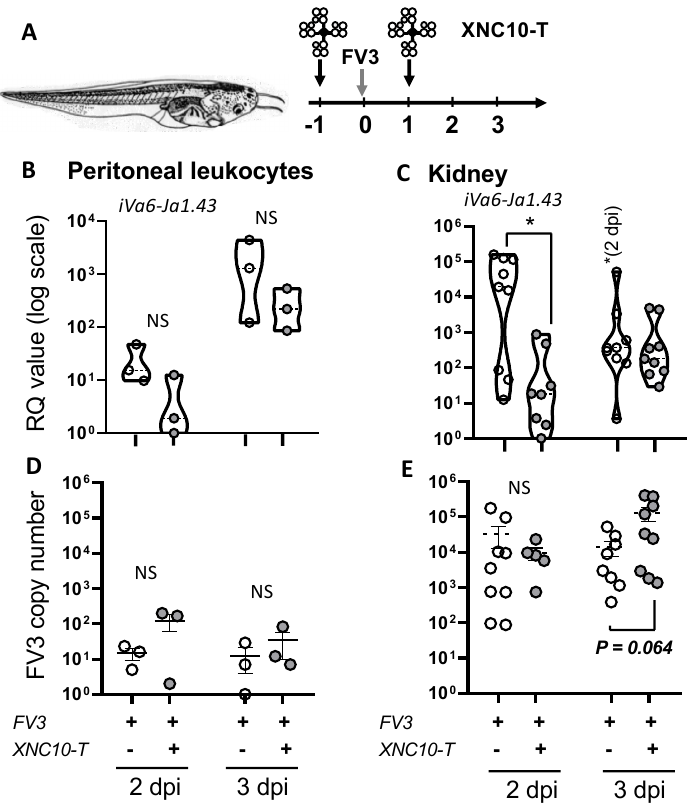
Figure 4. XNC10 tetramer-mediated iV α 6T cell depletion in tadpoles a ff ects iV α 6-J α 1.43 transcript levels and viral replication. PLs and kidneys were collected from three week-old (stage 55) tadpoles that had been injected with 1 µ g XNC10 tetramers (XNC10-T) or vehicle control 1 day pre, and 1 day post i.p. injected with 10,000 PFUs of FV3, at the indicated time points ( n = 9). A schematic of the injection regime is shown in ( A ). Gene expression of iV α 6-J α 1.43 in PLs ( B ) and kidneys ( C ) is shown. Results are normalized to an endogenous control and presented as relative expression compared with the lowest observed value according to the ∆∆ Ct method. FV3 loads in PLs ( D ) and kidneys ( E ) were measured using absolute qPCR with primers against FV3 polymerase II. For PLs, each dot represents a pool of 3 tadpoles, while for kidneys, each dot represents a single tadpole; * p < 0.05 denotes statistically significant di ff erences between the indicated groups; NS indicates no significant di ff erences (One way ANOVA followed by Tukey’s multiple comparison